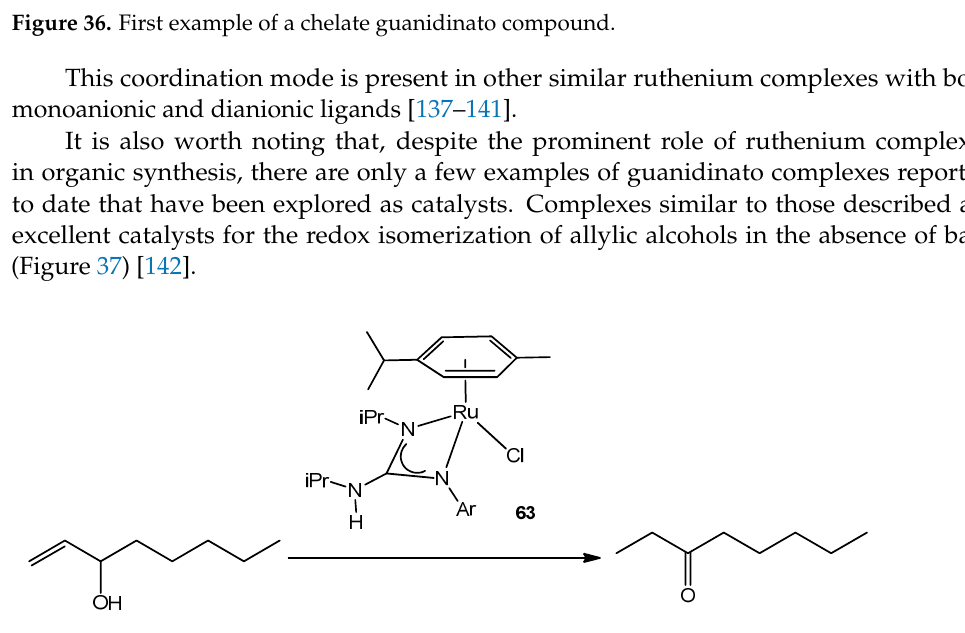
Figure 36. First example of a chelate guanidinato compound.